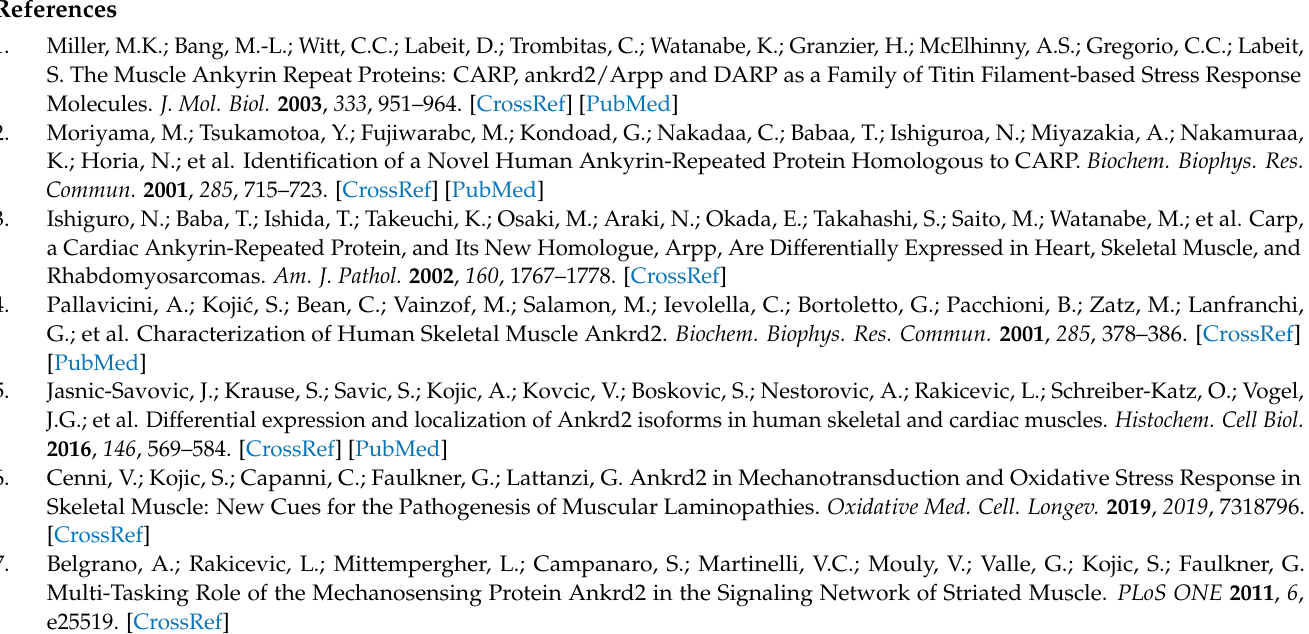
Figure S1B: Original uncropped blots of Figure 1B; Figure S2: Immunofluorescence analysis of endogenous Ankrd2 in U2OS and HOS cell lines; Figure S2A: Original uncropped blots of Figure 2A; Figure S2B: Original uncropped blots of Figure 2B; Figure S3: Analysis of subcellular distribution of ectopically expressed Ankrd2wt in Ankrd2-overexpressing clones from hFOB, Saos2, U2OS, HOS and MG63 cell lines, Figure S4: Analysis of Ankrd2 expression level in clones of U2OS and HOS cells stably expressing a Si-Ankrd2 transcript, Figure S5: Effects of ectopic expression of Ankrd2 in a cell line derived from human rhabdomyosarcoma, Table S1: List of primers used for RT-PCR and qPCR amplification of Ankrd2 and GAPDH fragments, Table S2: Average Ct ± SD values for ANKRD2 and GAPDH genes in cell lines derived from human osteoblasts (hFOB) and human